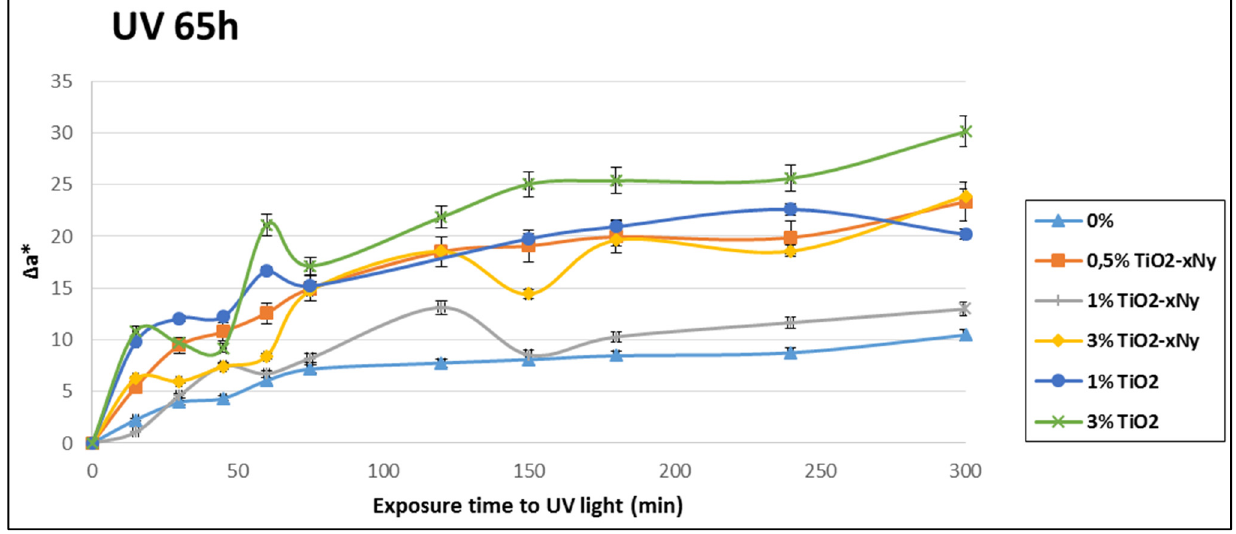
Figure 3. Change in Δ a * during five hour exposure to UV light with different addition percentages of TiO 2 − x N y and TiO 2 for samples at 65 h of curing